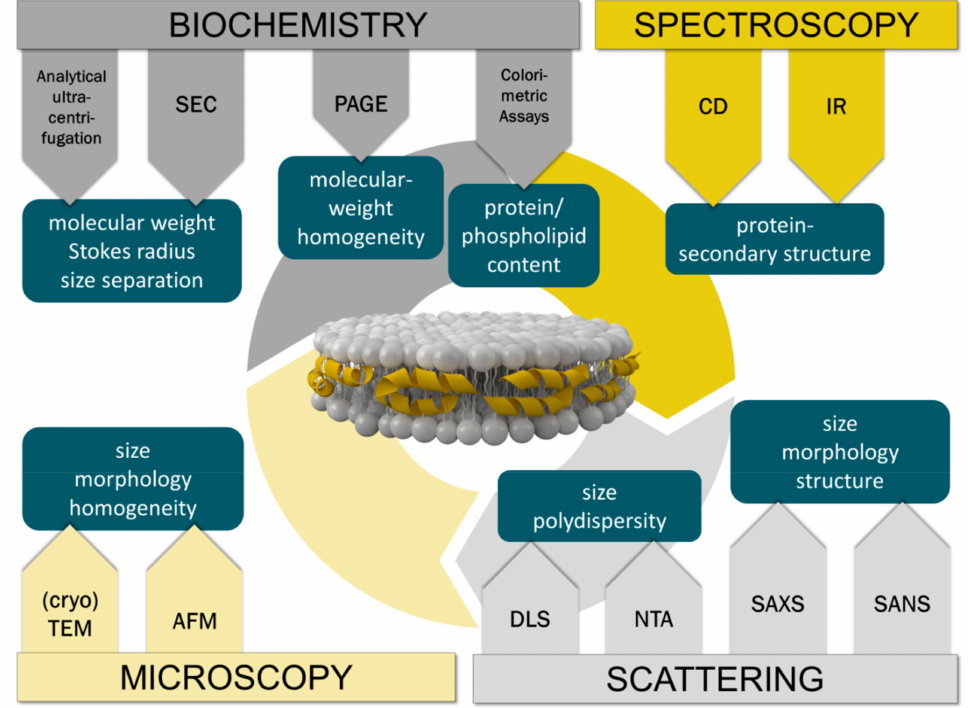
Figure 6. Overview of the physicochemical techniques commonly used for the characterization of rHDL particles. The methods are grouped into four main categories indicating the information obtained from each